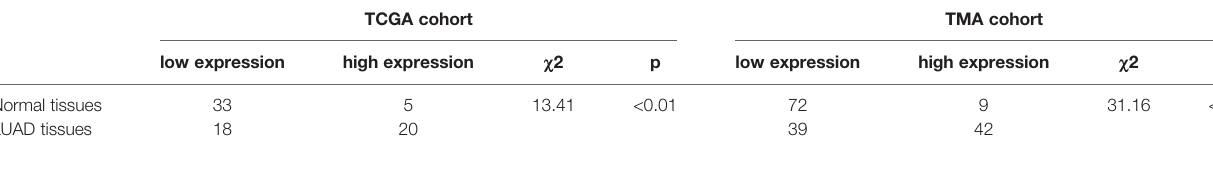
TABLE 1 | Differential expression of GBE1 in LUAD and normal tissues by utilizing the TCGA and TMA cohorts. TCGA